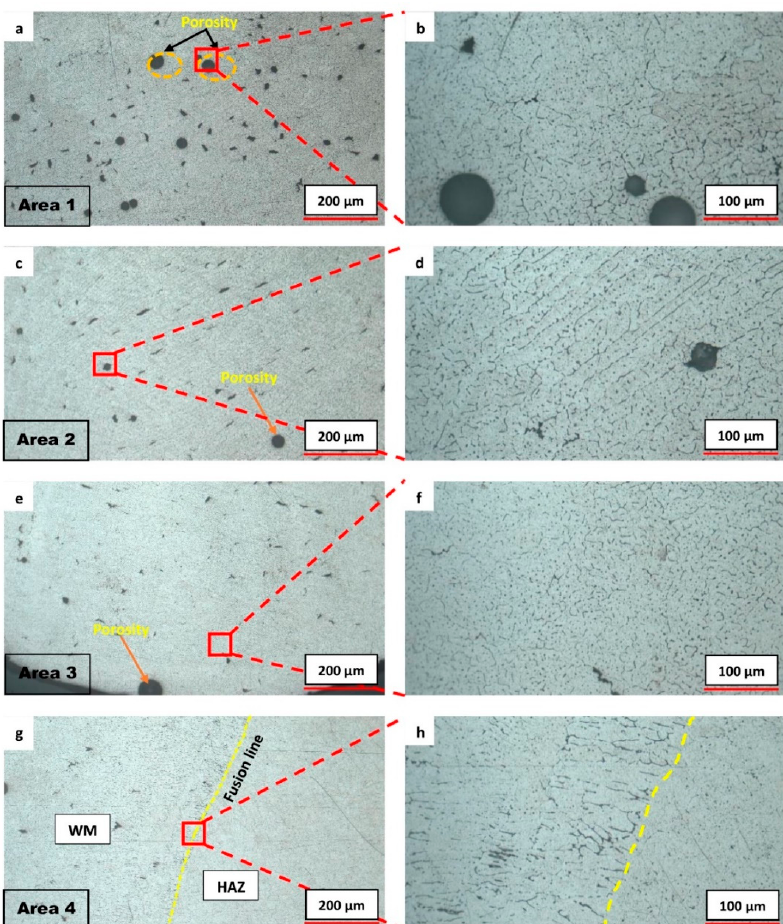
Figure 10. The microstructure of ( a , b ) area 1 with parameter code 4-a in low magnification and high magnification, ( c , d ) area 2 with parameter code 5-a in low magnification and high magnification, ( e , f ) area 3 with parameter code 6-a in low magnification and high magnification and ( g , h ) area 4 with parameter code 4-a in low magnification and high magnification.